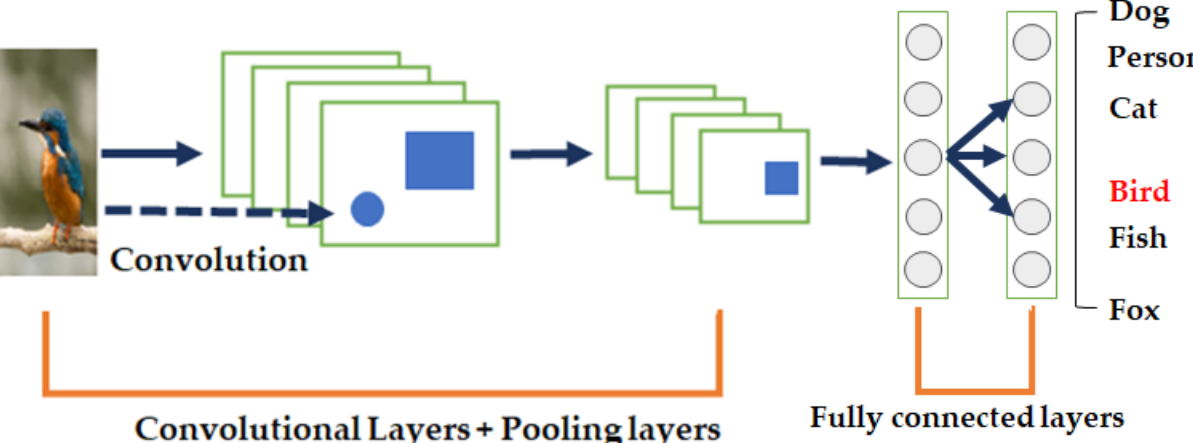
Figure 3. The pipeline of the general CNN architecture. A CNN typically consists of three main neural layers: the convolutional layer, pooling layer, and fully connected layer, which play different roles.